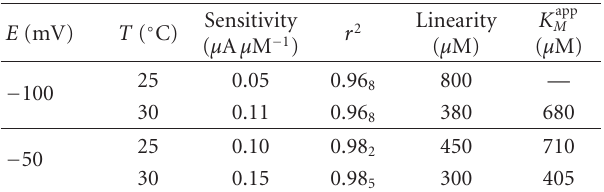
Table 2: Operational parameters of glucose oxidase enzyme elec- trode at temperatures 25 and 30 ◦ C; applied potentials − 100 and − 50 mV (Ag/AgCl, 1MKCl); background electrolyte: phosphate- citrate bu ff er pH